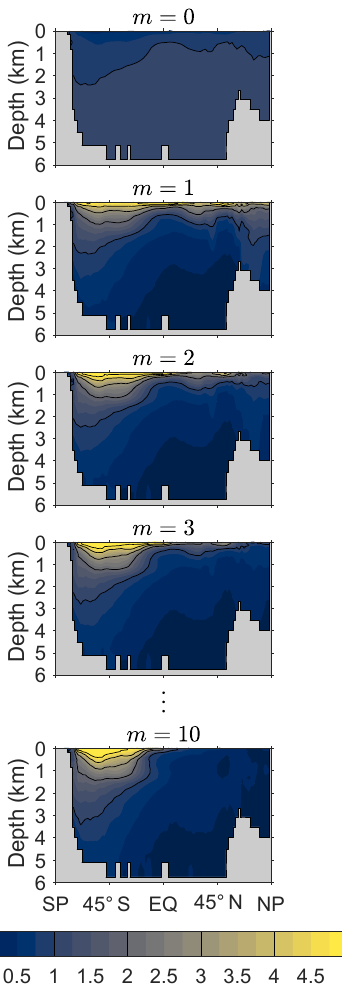
Figure 8. Global zonal averages of the fraction of DFe that will be regenerated m times, f m ↑ , normalized by its global mean value, (cid:104) f m ↑ (cid:105) , for m = 0 , 1 , 2 , 3 , and 10. This figure is for our typical state.